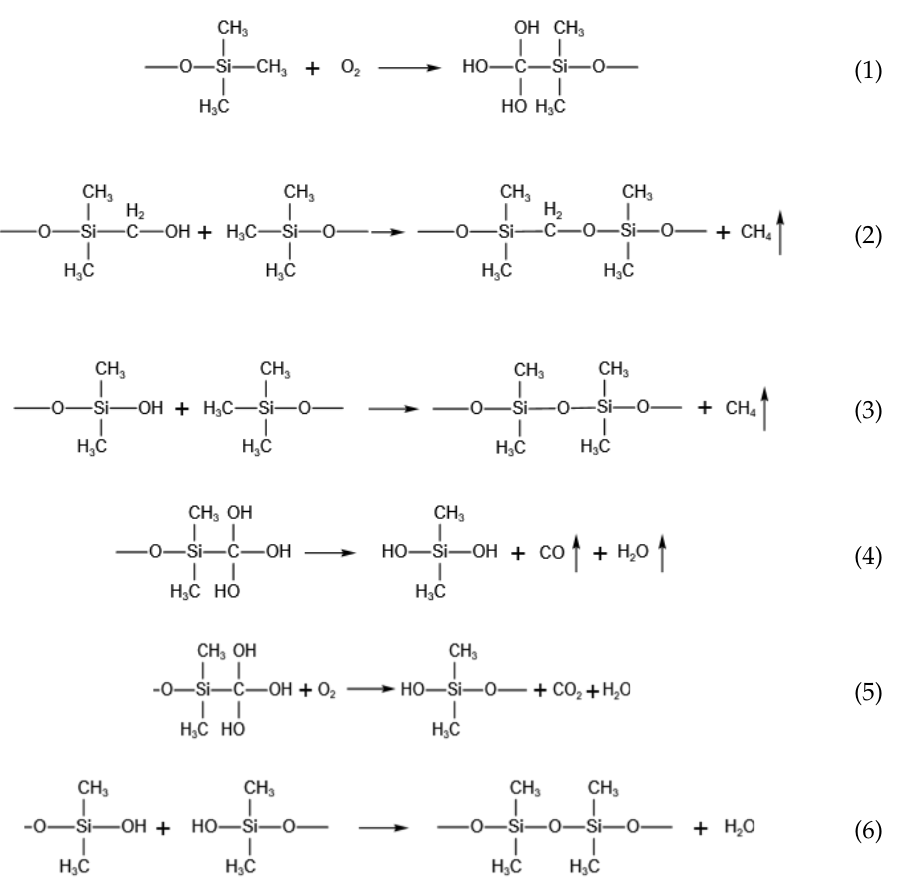
Figure 7. The chemical pyrolysis process of silica aerogel.